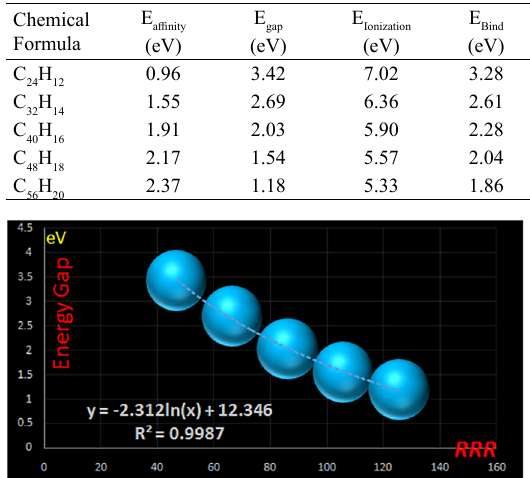
Figure 1. Energy Gap changes in Circumacenes family according to RRR index.